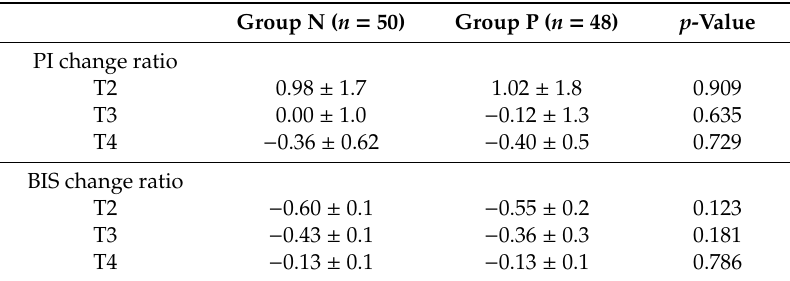
Table 2. Perfusion index and bispectral index change ratios over time.